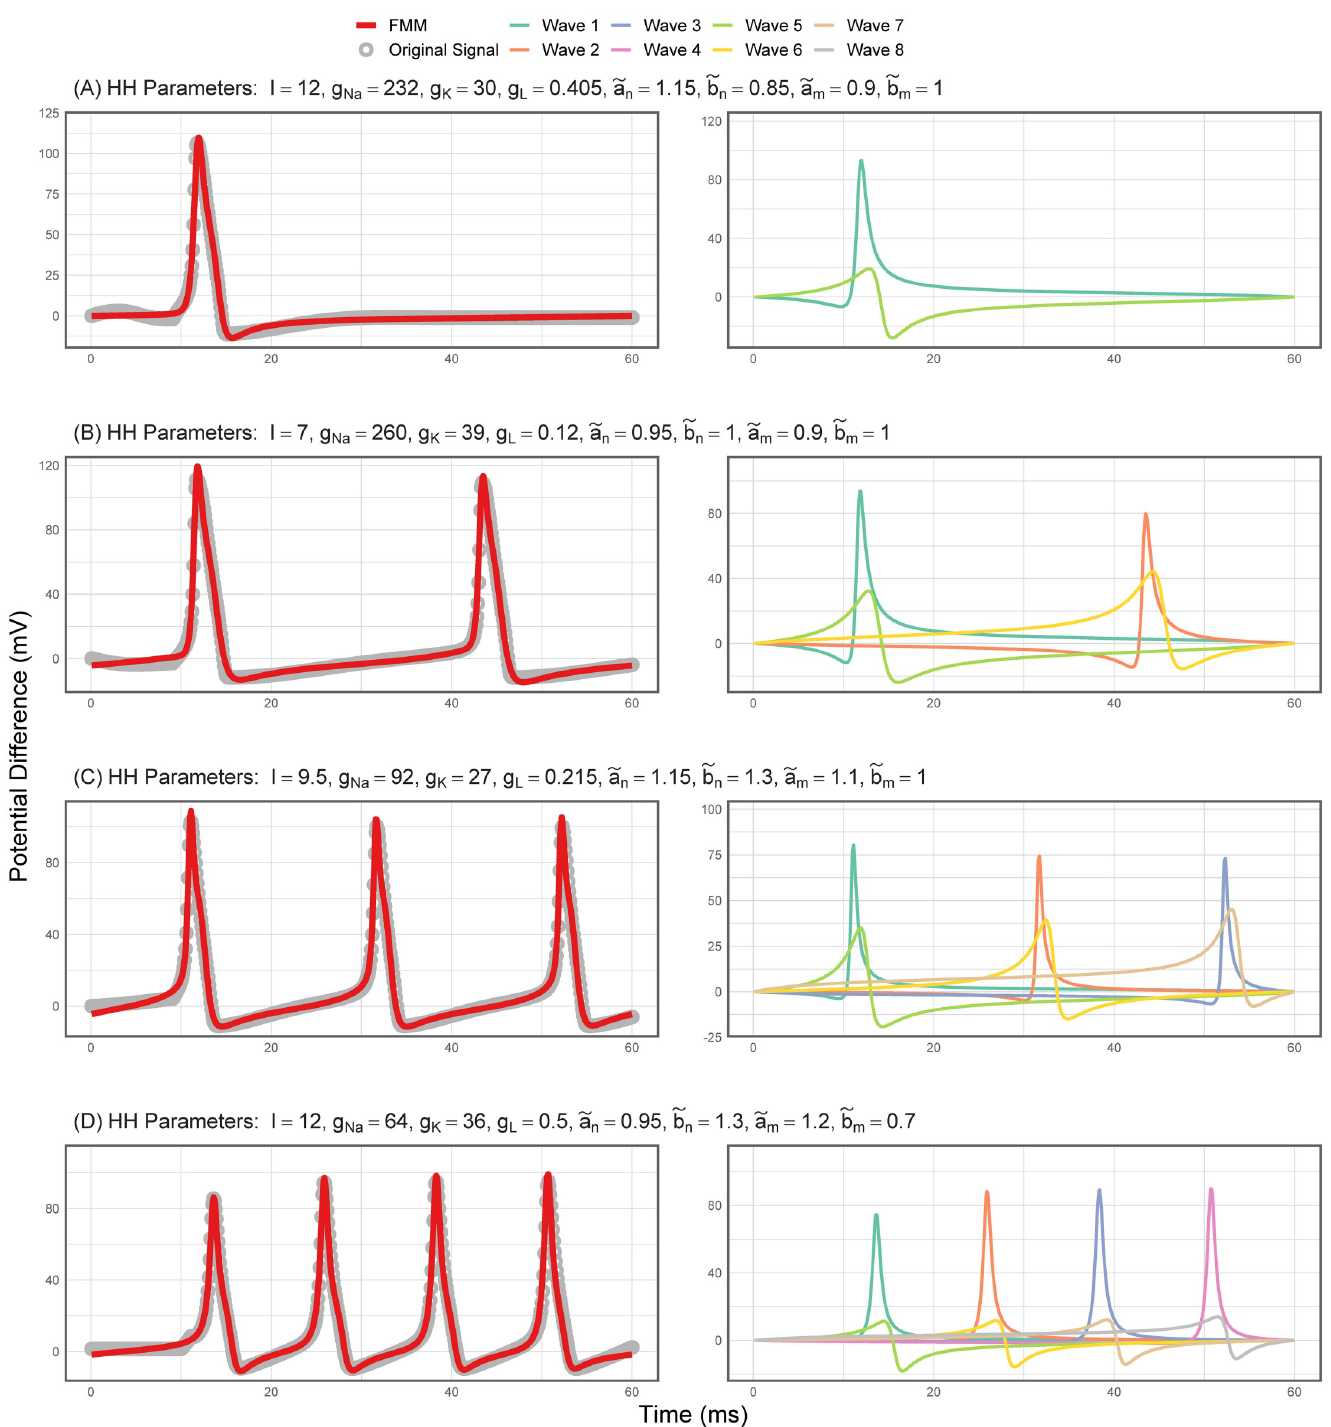
Fig 3. Neuronal signals simulated with the HH model and the estimated FMM ST signals in red (left) . Waves of the fitted FMM ST model (right), which have been enumerated according to relevance and order.